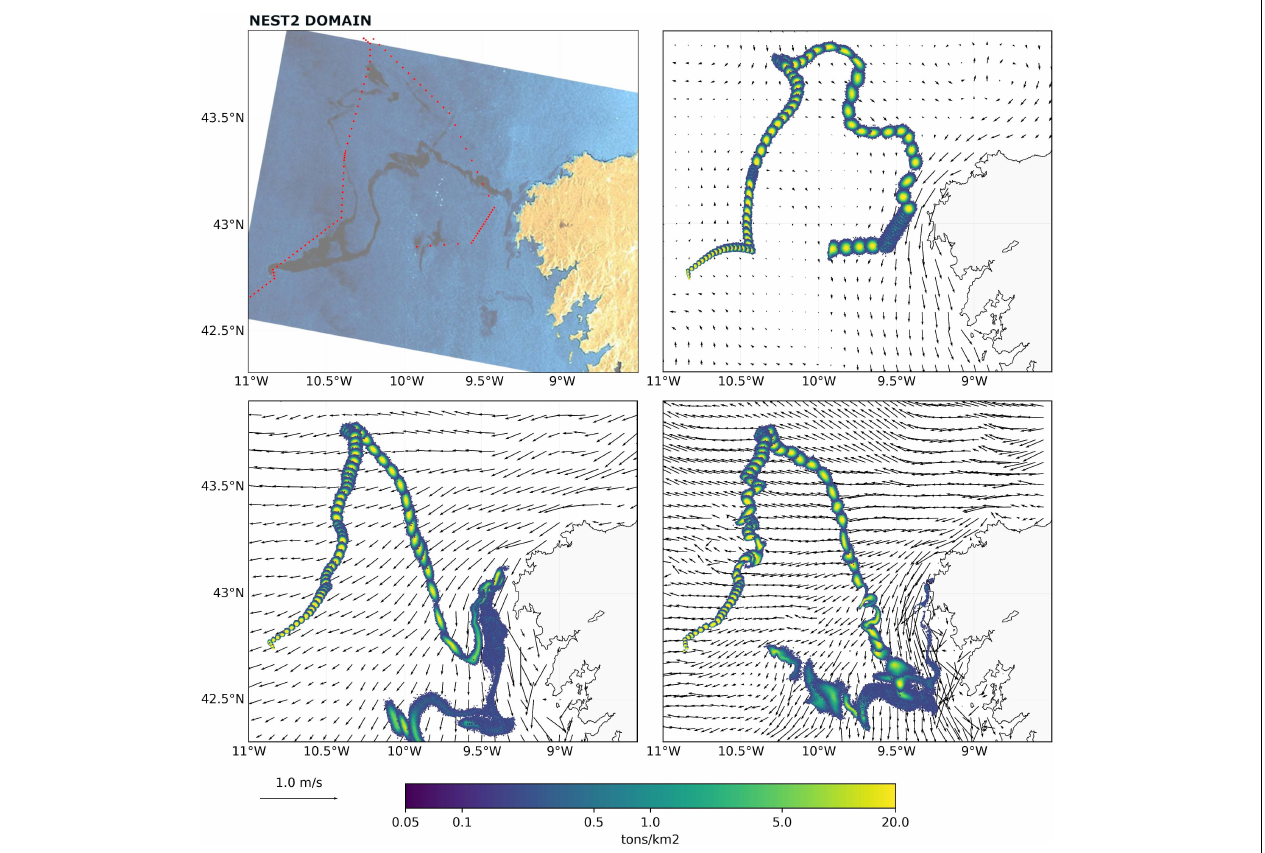
FIGURE 9 | ESA Satellite image of 17 November at 10:45 ( top-left panel ) showing the wake of fuel oil in black. Red dots indicate the location of the release points assumed. Simulated drift of a continuous leak of fuel oil along the trajectory taken by the Prestige from 13 November at 15:00 to 17 November at 11:00 forced by 3 different model CMEMS ( top-right panel ), NEST1 ( bottom-left panel ), and NEST2 ( bottom-right panel ) with increasing grid resolutions of 8000, 2000, and 500 m. Black arrows, whose length is proportional to velocity, denote the direction and strength of the ocean currents. Arrows are subsampling every 1 (CMEMS), 4 (NEST1), and 10 (NEST2) grid